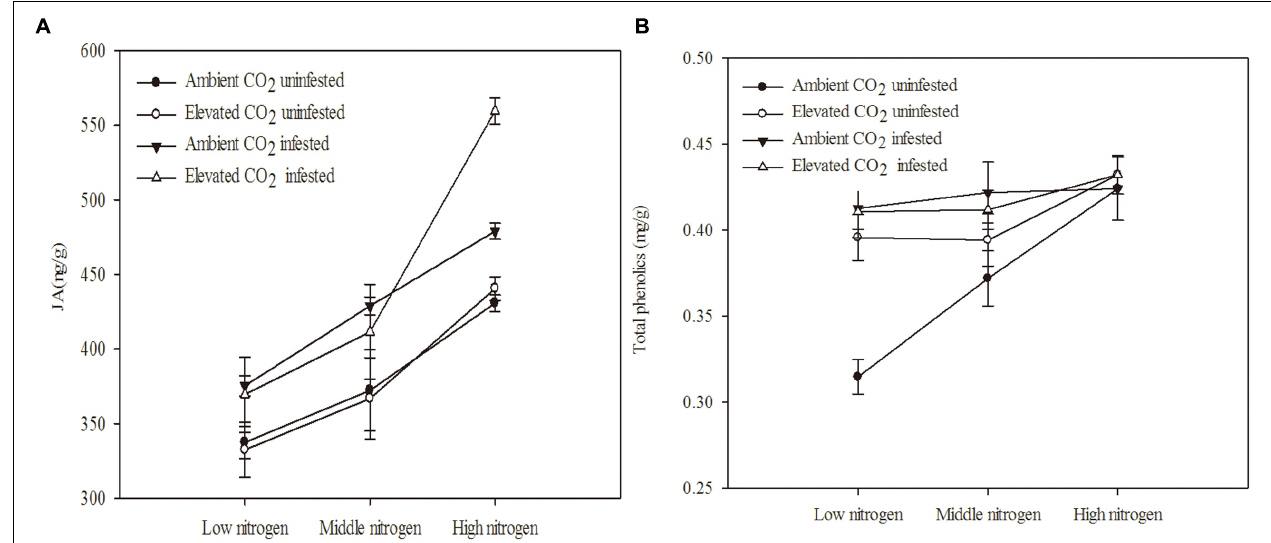
FIGURE 2 | Defensive chemical components of maize grown under different levels of CO 2 and nitrogen fertilization conditions (mean ± SE, n = 3). (A) Jasmonic acid (JA), (B) total phenolics.